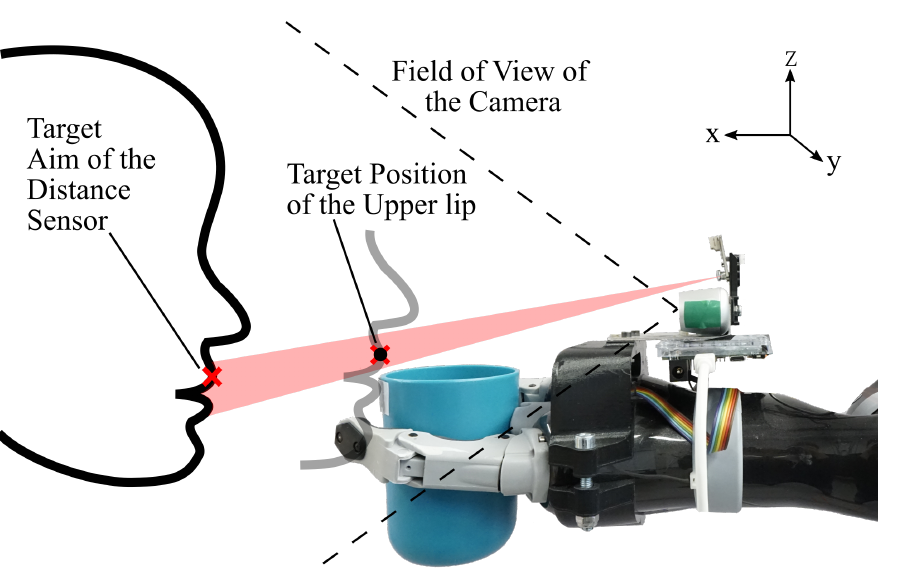
Figure 2. Physical setup of the visual tracking system. The dotted line represents the field of view of the camera. The red ray illustrates the field of view of the distance sensor. The black dot and transparent face illustrate the target position of the cup. The red cross represents the point where the distance sensor is supposed to be aimed at to measure the distance to the